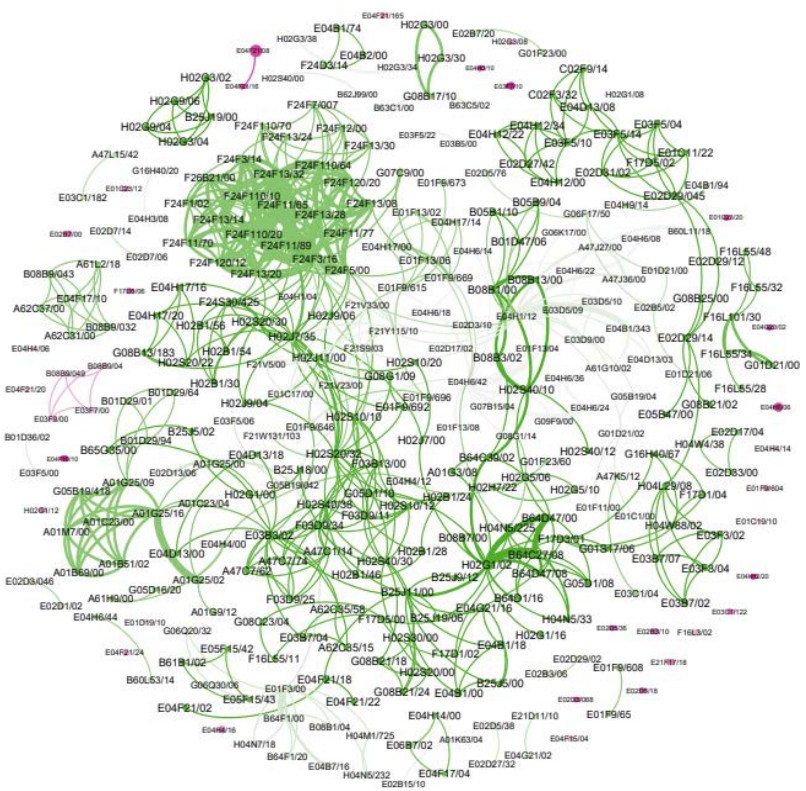
Figure 8. Digital construction innovation network (2018).